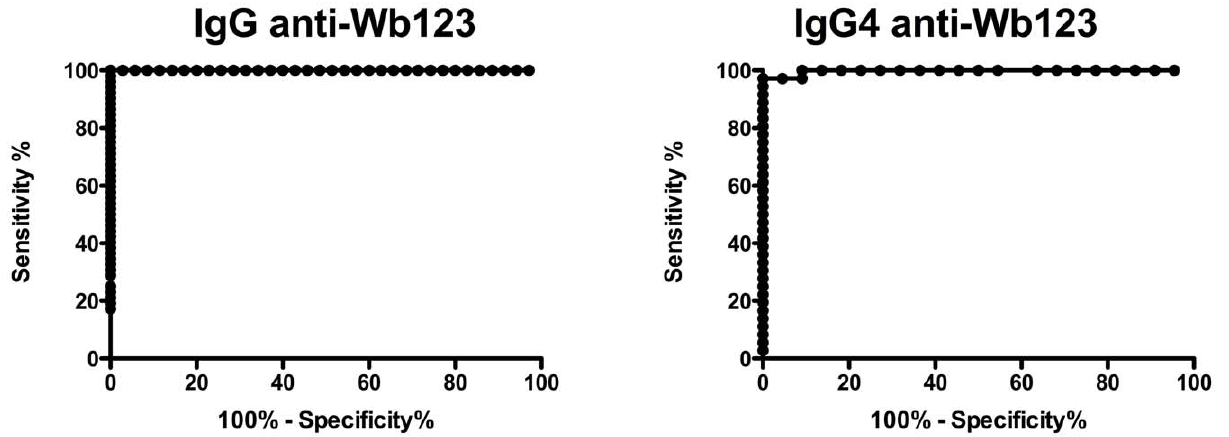
Figure 2. ROC Analysis Wb123 antibody responses. Receiver operating characteristic (ROC) analysis using serum samples from Wuchereria bancrofti -infected subjects (n=43) and normal North American non-travelers (n=50) for IgG (Left panel) and IgG4 (Right panel) anti-Wb123 antibodies.